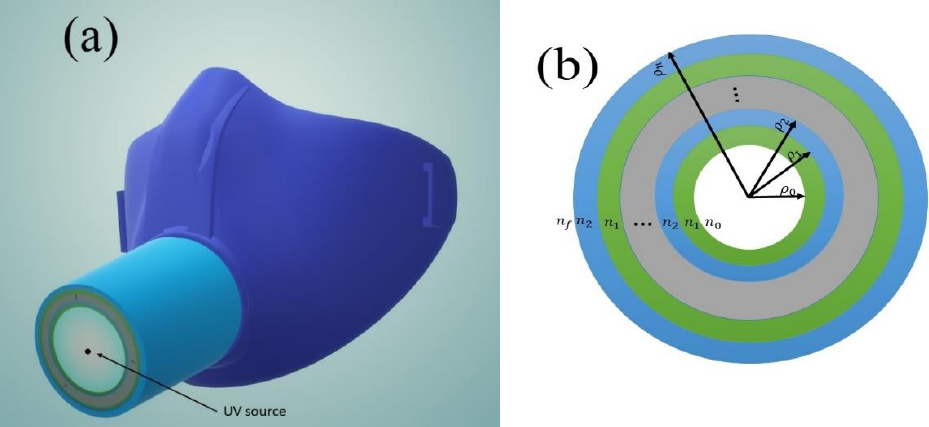
Figure 1. Schematic diagram of the proposed design including: ( a ) the mask design where the mask’s body is sealed to the face; and ( b ) diagram of a planer view of the annular photonic crystal (APC) inside the mask with an internal radius 𝜌 0 where air enters the tube and concentric periodic cylinders with radii 𝜌 𝑖 .